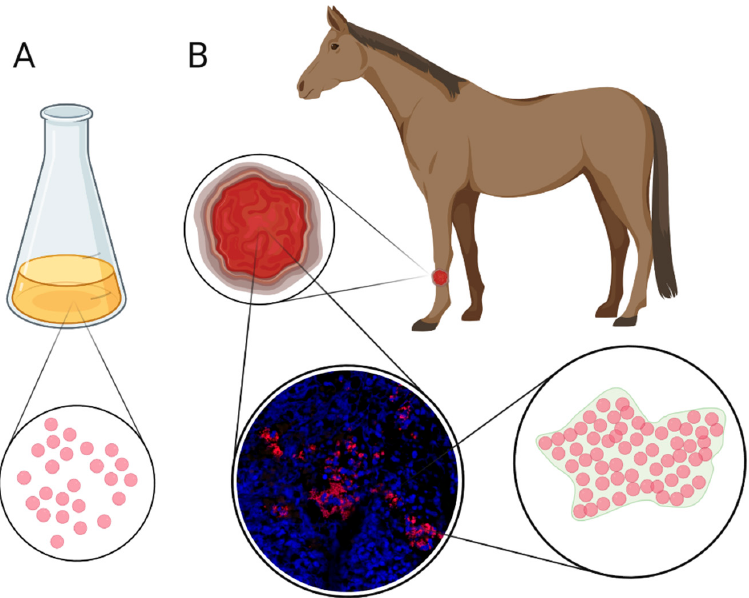
Figure 1. ( A ) Normally bacteria growing in shaken cultures in the lab are planktonic (single cells); ( B ) Bacteria in most situations in nature, including wounds, are present as biofilms. Biofilms are aggregates of bacteria, and within these biofilms, the bacteria are protected from immune defences and antimicrobial products. The microimage shows bacterial biofilm in an equine limb wound biopsy detected with peptide nucleic acid (PNA) fluorescence in situ hybridization (FISH) and subsequent confocal laser scanning microscopy (CLSM). Bacterial ribosomal RNA is displayed with a red fluorophore and eukaryotic cell nuclei (DNA) are blue due to DAPI stain (4 ′ ,6 ′ -diamidino-2-phenylindole). Many eukaryotic cell nuclei (seen as blue spots) surround the biofilms and leaked DNA (blue stain not shaped as nuclei) from the cells can be seen, this leaked DNA is most likely from neutrophils dying in the combat against the biofilms. Figure created with BioRender.com (accessed on 07 July 2021).